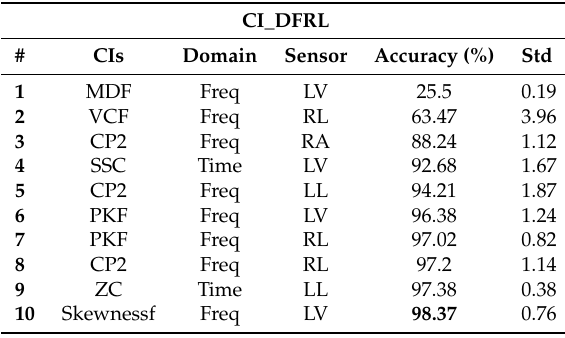
Table 10. Top 10 features and accuracies average over time and frequency domain using all sensors, CI_DFRL.